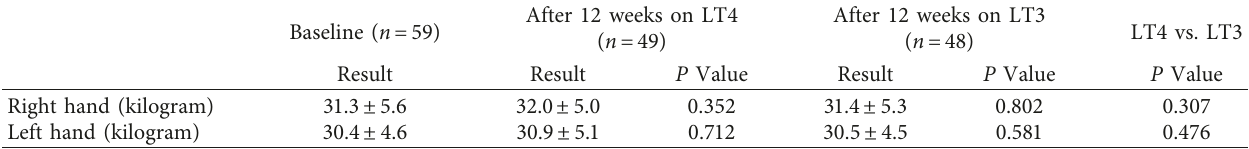
Table 3: Handgrip strength.